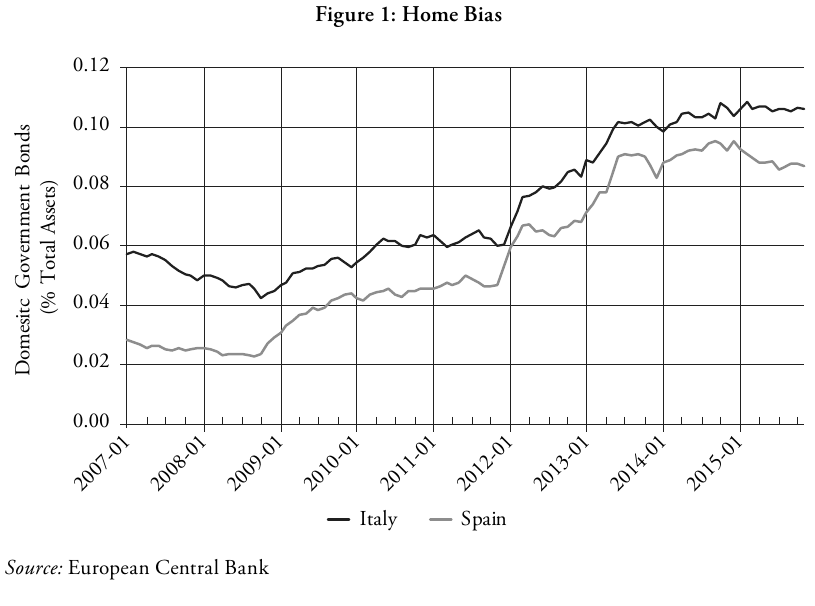
Figure 1: Home Bias